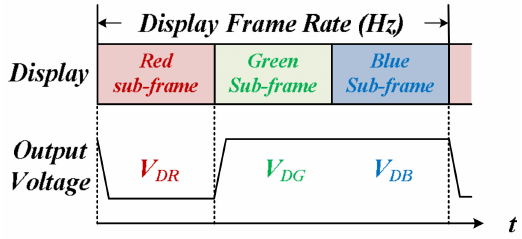
Figure 1. Concept of frequency-sequential-color technique.